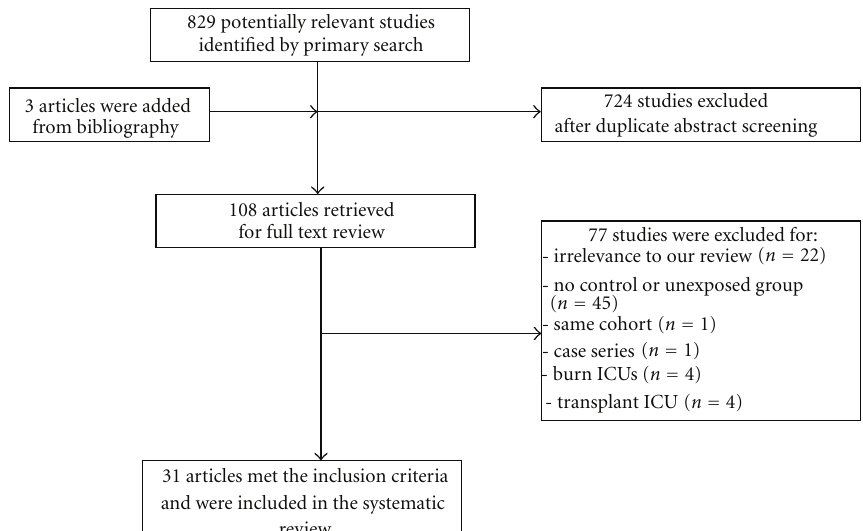
Figure 1: Flow diagram of the process of study